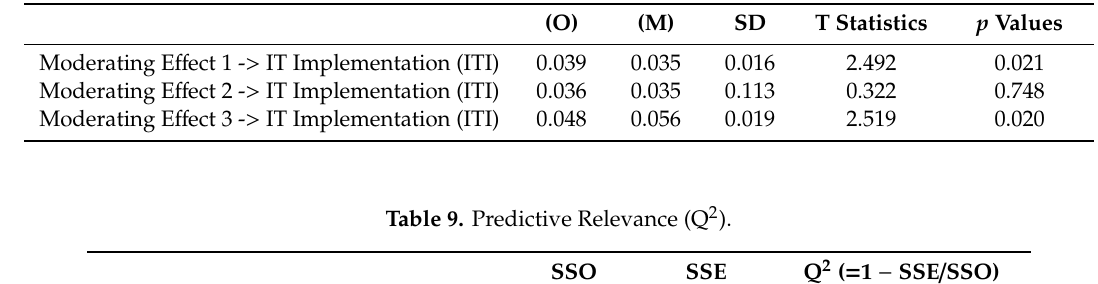
Table 8. Moderation E ff ect.